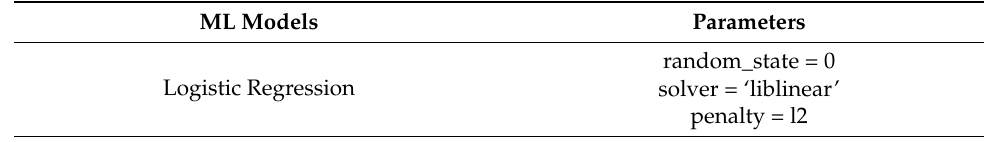
Table 3. Model parameters for Logistic regression, SVM and Random Forest